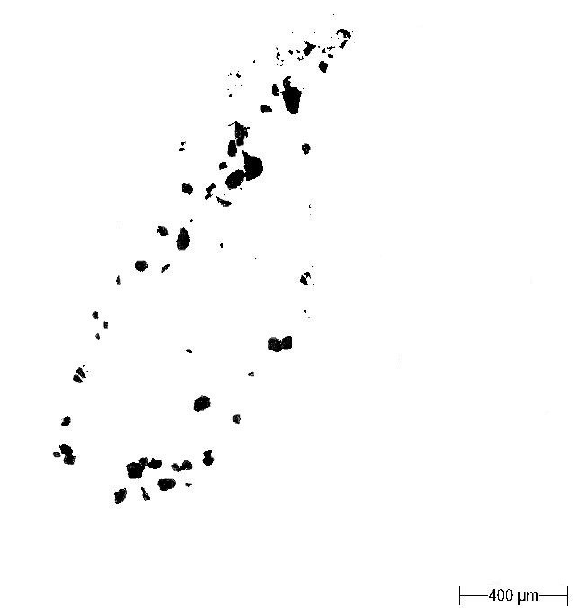
Figure 4. The same soil particles as Figures 2 and 3 after correction in the GIMP program.